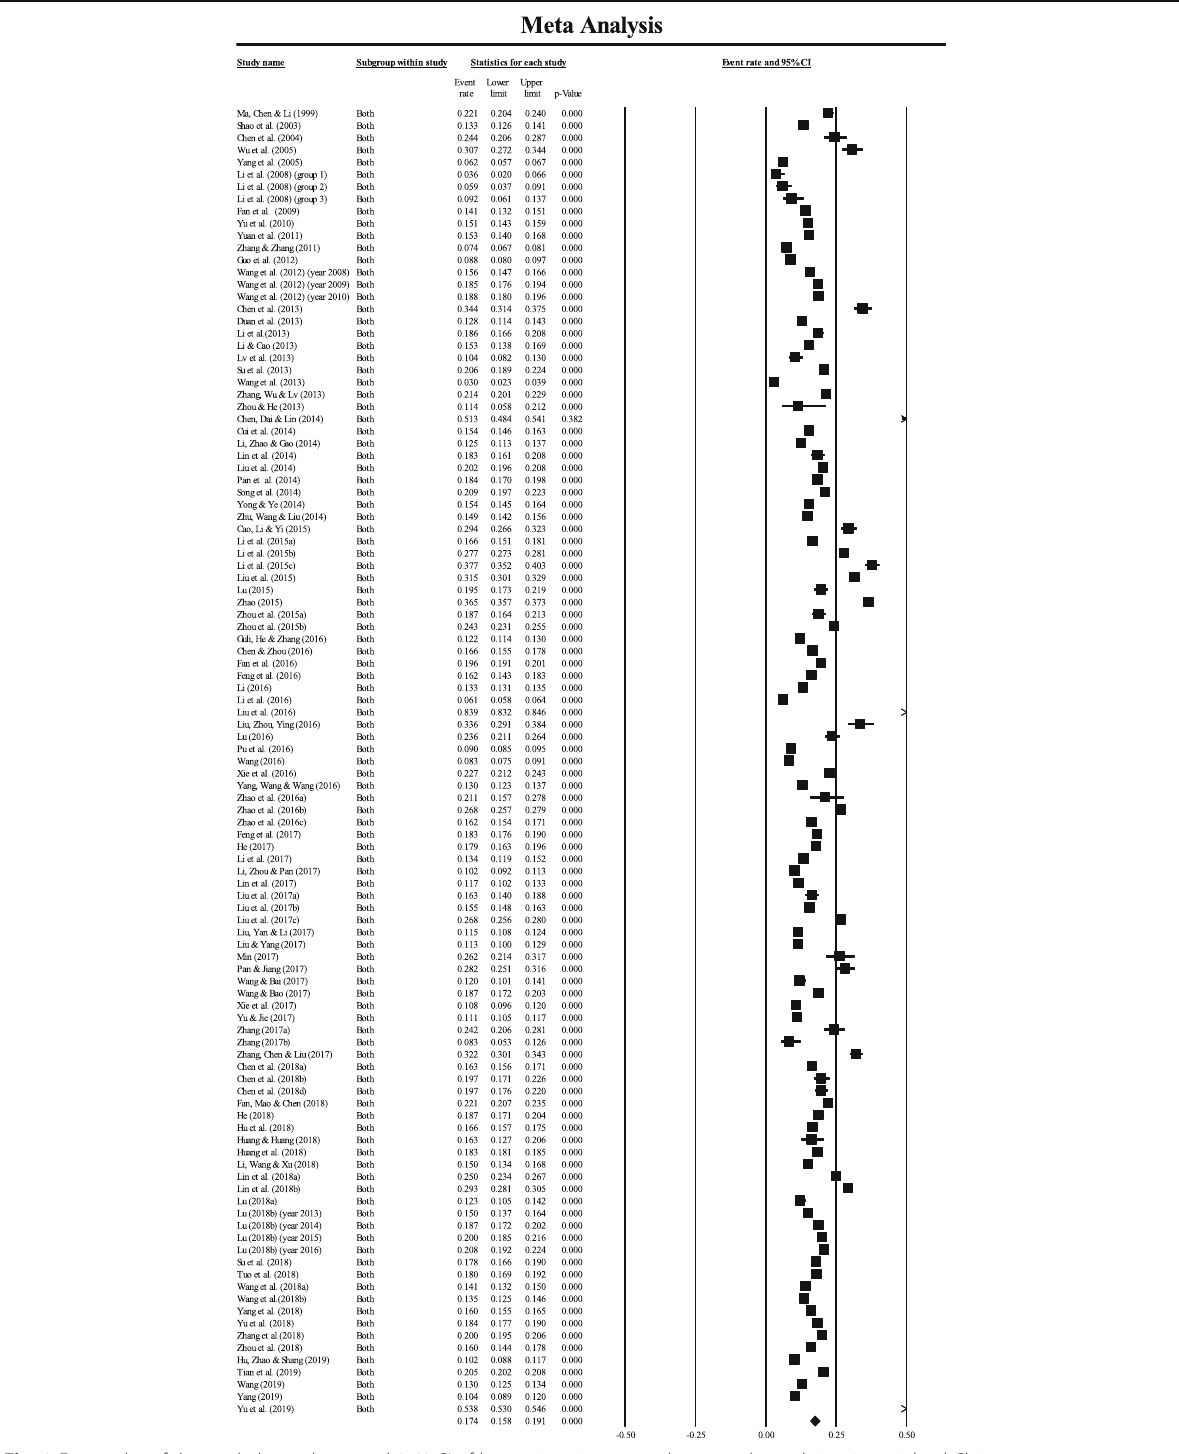
Fig. 2 Forest plot of the pooled prevalence and 95% CI of hyperuricemia among the general population in mainland